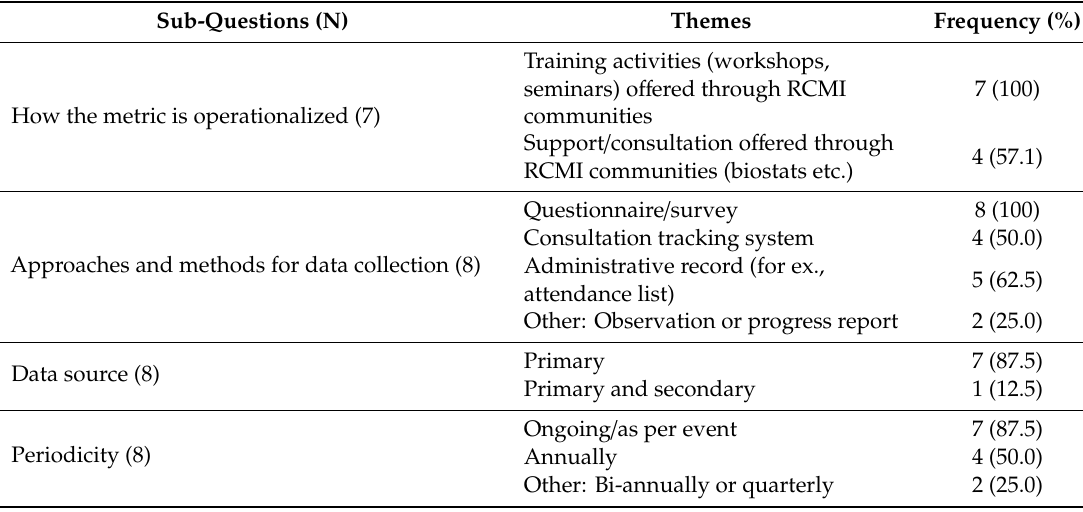
Table 6. Primary target: Expand research resources. Key findings of the case study regarding the operationalization and data collection strategies for the metric “number of biostatistics consults, workshops, seminars, and